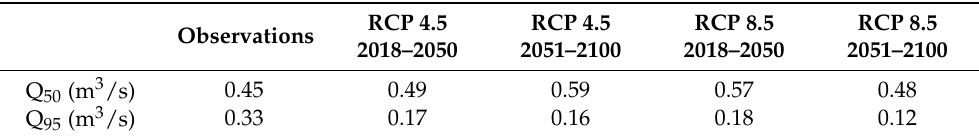
Table 3. Environmental flow statistics for August–September observations and two climate change scenarios on the Wilmot River.